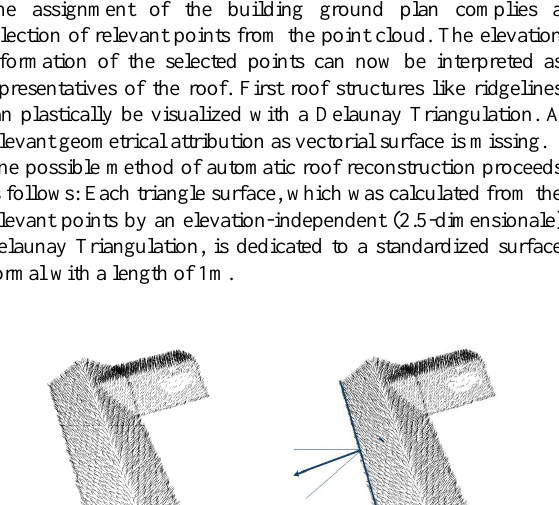
Figure 3. classification of a surface normal respectively to one side of the building (left), reduction of the classes to the distinctive sides of the building